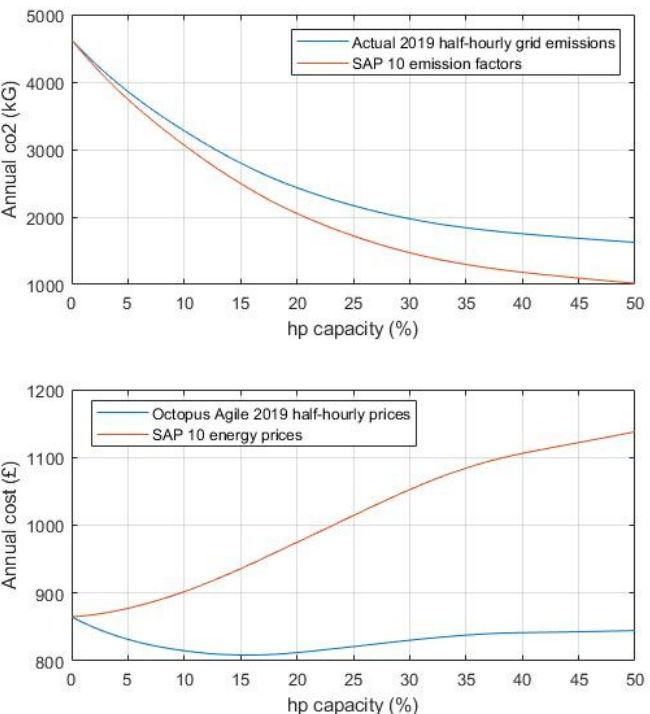
Figure 8. CoCo hybrid annual fuel costs and CO 2 emissions, based on fixed prices and emissions factors (SAP) and half-hourly varying prices and emissions (Octopus Agile and actual emissions data), for OXF1.